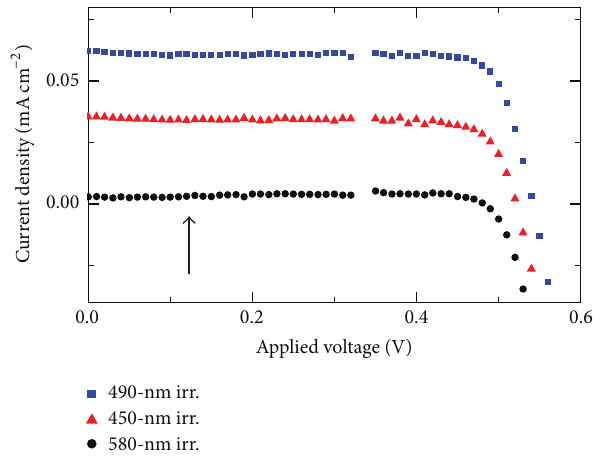
Figure 8: I - V profiles of the Ru-dye/CM- 𝛽 -CD-containing device measured under 580, 490, and 450 nm light irradiation.